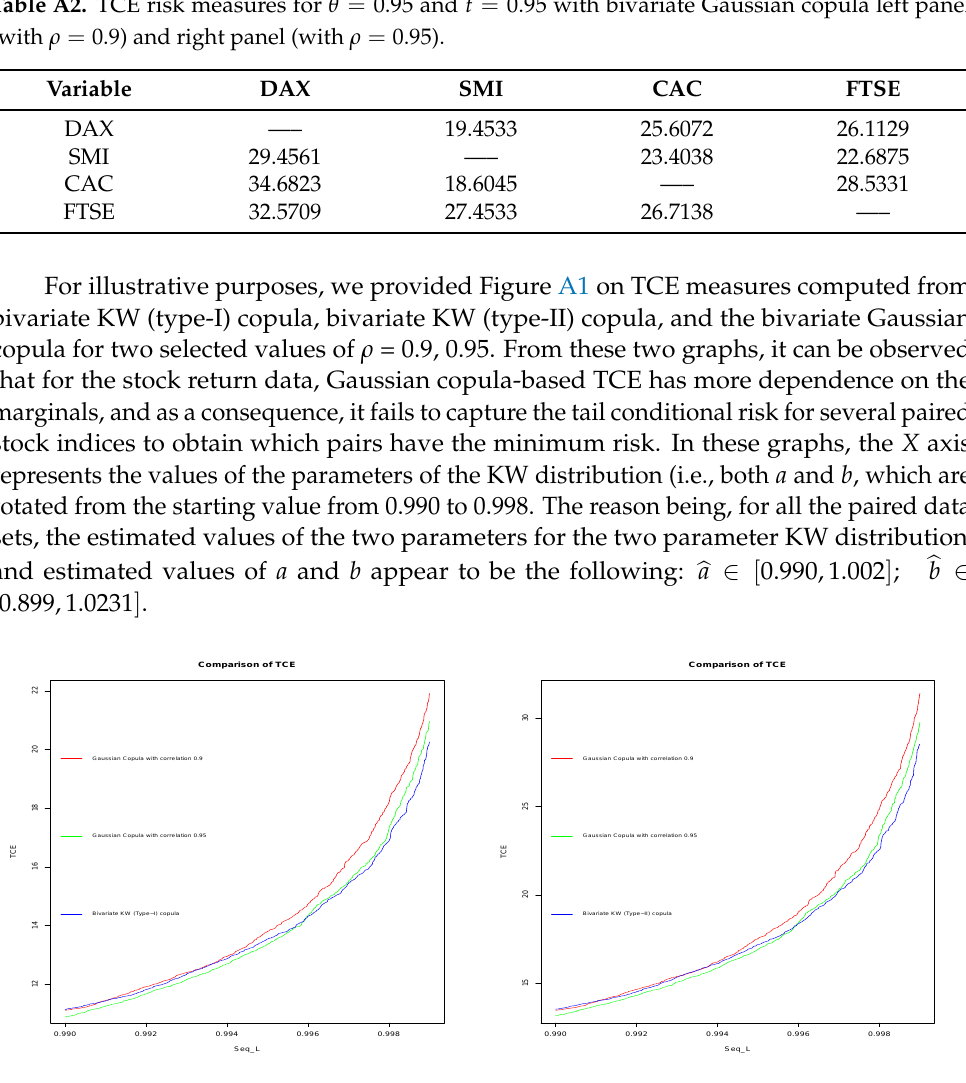
Figure A1. Comparison of TCE measures based on the bivariate KW (type-I) copula, a bivariate KW (type-II) copula with a bivariate Gaussian copula for the selected parameter choices of KW distribution obtained from the stock return